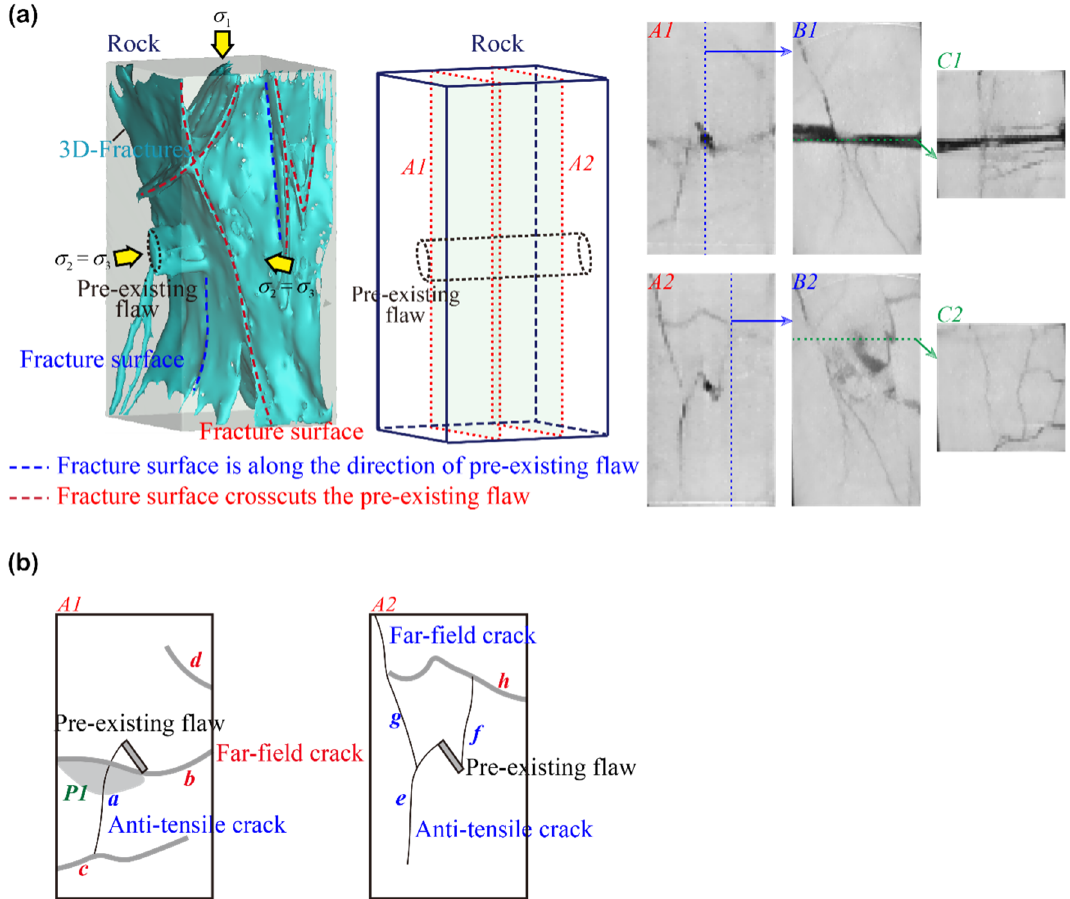
Figure 8. ( a ) Distribution of internal fissures in rocks with prefabricated fissures under the CTT condition; ( b ) Various crack types from a single fissure identified.